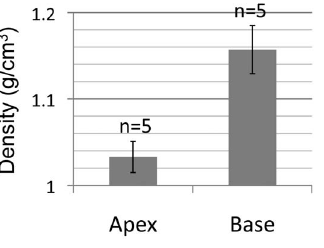
Figure 2. Density difference between the apex and the base of Thalassiahemprichii seeds. Error bars indicate 95%